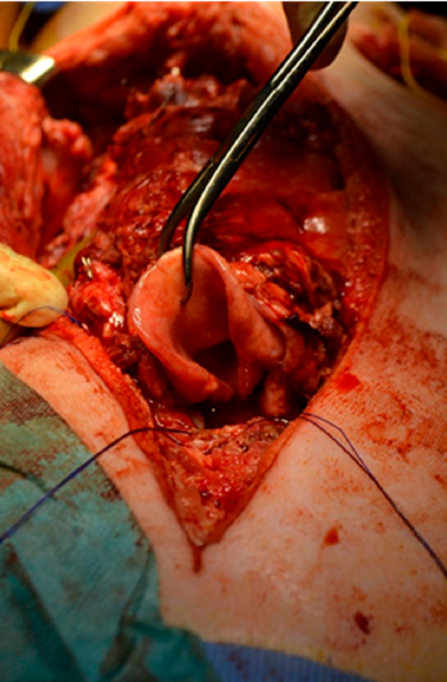
Figure 4. Once the anastomoses had been carried out, the vessels were de-clamped and perfect in vivo revascularisation of the transplant could be observed after a few minutes. An endoscopy was immediately performed after the surgery in the third recipient animal and confirmed the correct revascularisation of the transplant (Figure 5).